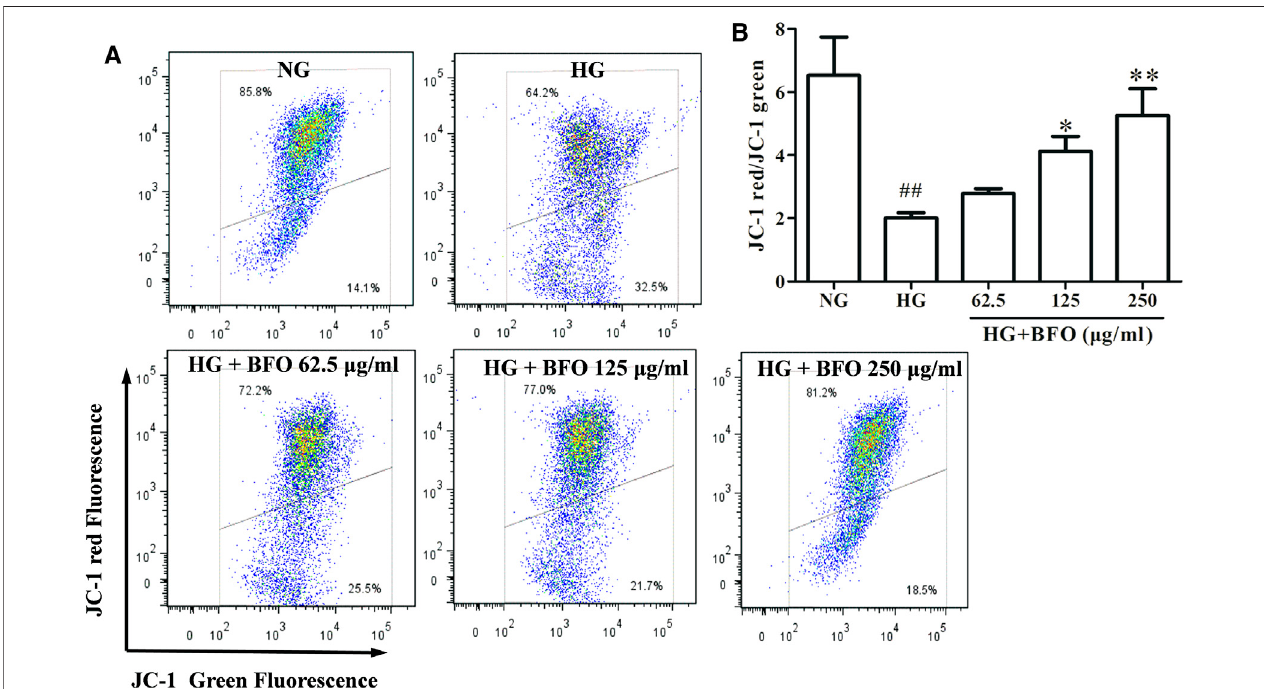
FIGURE 5 | Effect of BFO on mitochondrial membrane potential in NRK-52E cells. (A) Representative images of mitochondrial membrane potential determined by fl owcytometryusingtheJC-1probe. (B) HistogramrepresentingthequantitativeanalysisofmitochondrialmembranepotentialinNRK-52Ecells.Alldataareexpressed as the mean ± SD. ## p < 0.01 vs. normal glucose (NG), * p < 0.05 vs. HG, ** p < 0.01 vs. HG.